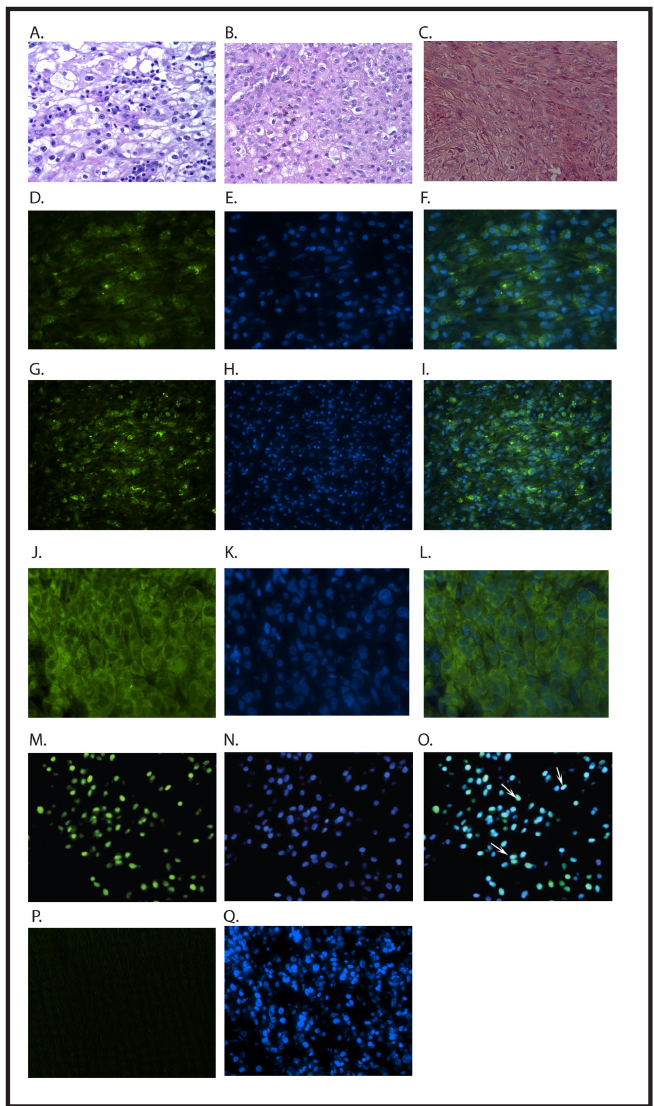
Figure 2. A) H&E section of patient’s primary tumor displaying classical chordoma histology. B) H&E section of patient’s